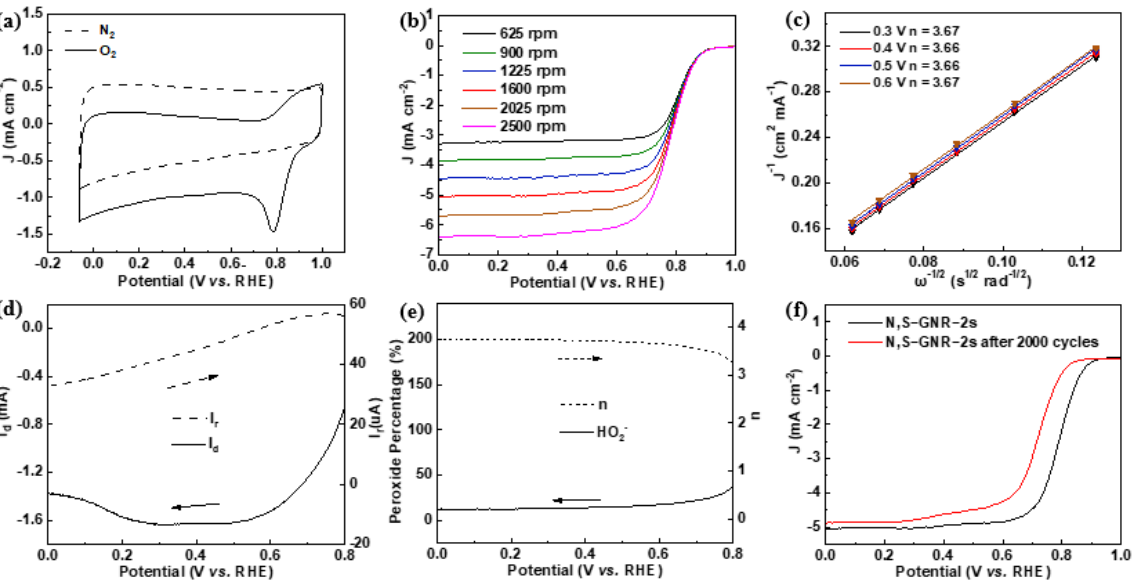
Figure 4. Electrocatalytic property tests of N, S-GNR-2s. ( a ) The CV test in 0.1 M KOH solution. ( b ) The RDE test at rotating speeds from 625 to 2500 rpm. ( c ) K–L plots based on the RDE test. ( d ) RRDE curves at a rotating speed of 1600 rpm. ( e ) The calculated HO 2 − yield and electron transfer number. ( f ) The stability test before and after 2000 cycles.